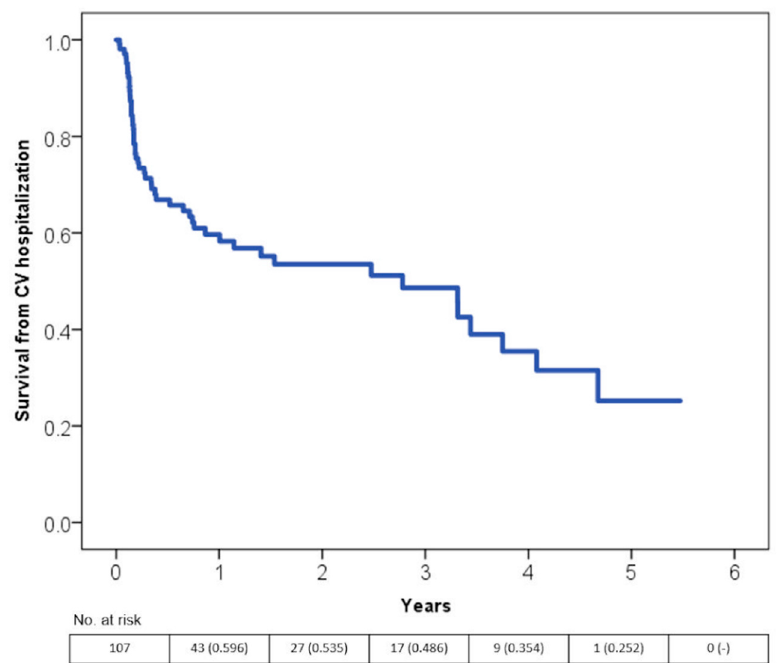
Figure 4. Time free from hospitalization for cardiovascular reasons according to the Kaplan-Meier curves.